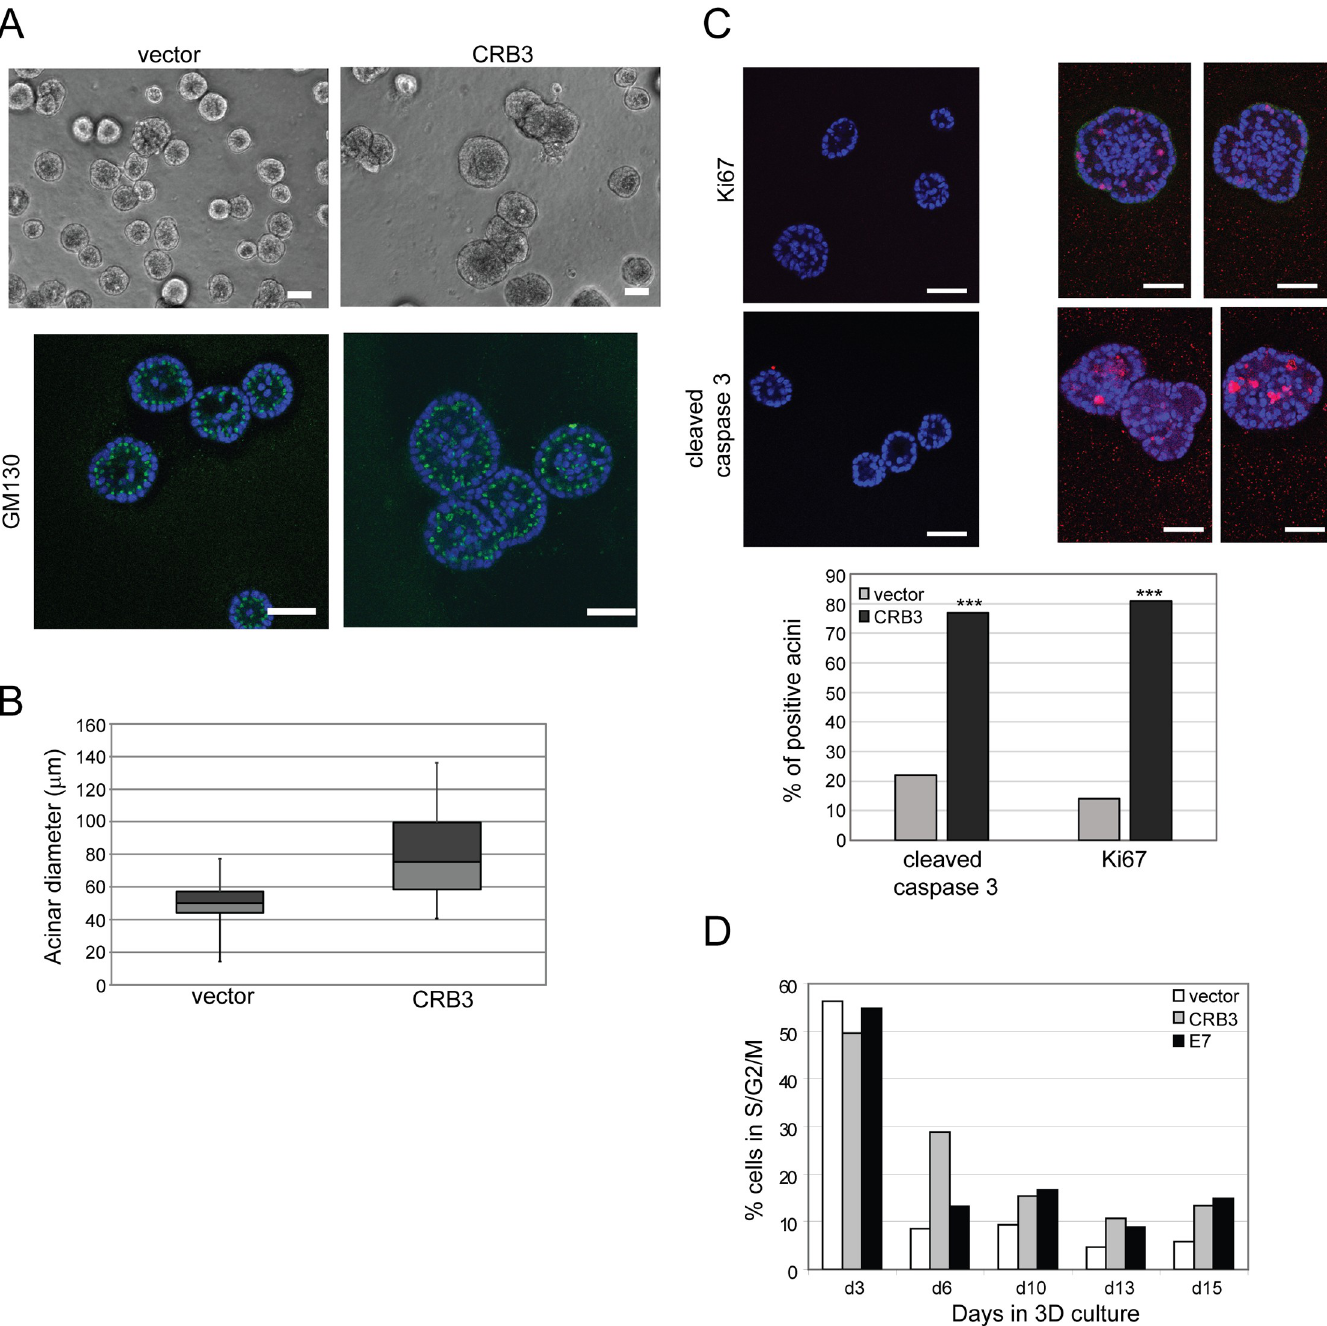
Fig 1. CRB3 expression leads to hyperproliferation and enlarged acini of MCF-10A cells. (A) MCF-10A cells expressing CRB3 cells were cultured on Matrigel for 13 days. Representative phase images are shown (top) along with equatorial TOPRO-3-stained (blue) confocal cross sections of structures and immunostained with the Golgi marker, GM130 (green). Representative images of are shown. Scale bars, 50 μ m. (B) The diameters of acini were measured in Image J using phase images of day 12 cultures, and a boxplot of acinar diameters from seven fields pooled from three independent experiments is shown (top). The light and dark grey boxes represent the lower and upper quartiles, respectively, with the median dividing the two boxes. The whiskers represent the minimum and maximum data points. The average acinar diameters +/- SEM were 49.4 +/- 1.4 μ m and 79.4 +/- 2.9 μ m for vector and CRB3 acini, respectively (p = 2.2 x 10 − 15 ). (C) MCF-10A cells expressing CRB3 were cultured on Matrigel for 13 days and equatorial TOPRO-3-stained confocal cross sections of structures immunostained with Ki67 (top) or cleaved caspase 3 (middle) are shown. Ki67, cleaved caspase 3 in red; TOPRO-3 (nuclei) in blue. Scale bars, 50 μ m. The percent of acini positive for either Ki67 or cleaved caspase 3 were quantified from acini pooled from three independent experiments (bottom). (Ki67: vector, n = 27; CRB3, n = 39; cleaved caspase 3: vector, n = 21, CRB3, n = 27; ��� p < 0.001 by Fisher’s exact test). (D) Single cell suspensions of the indicated cell types were prepared from cultures on the days indicated, labeled with propidium iodide, and analyzed by flow